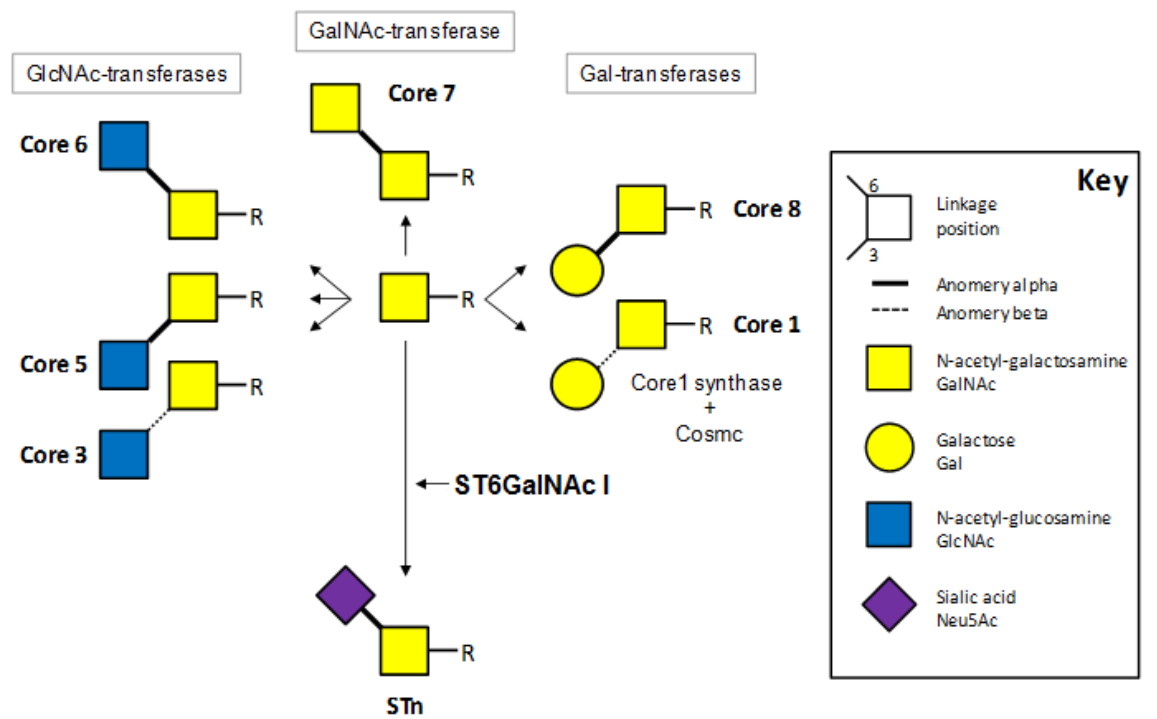
Figure 1. The initial steps of the O -glycan biosynthesis showing cores and sialyl-Tn (STn) competition for the initial